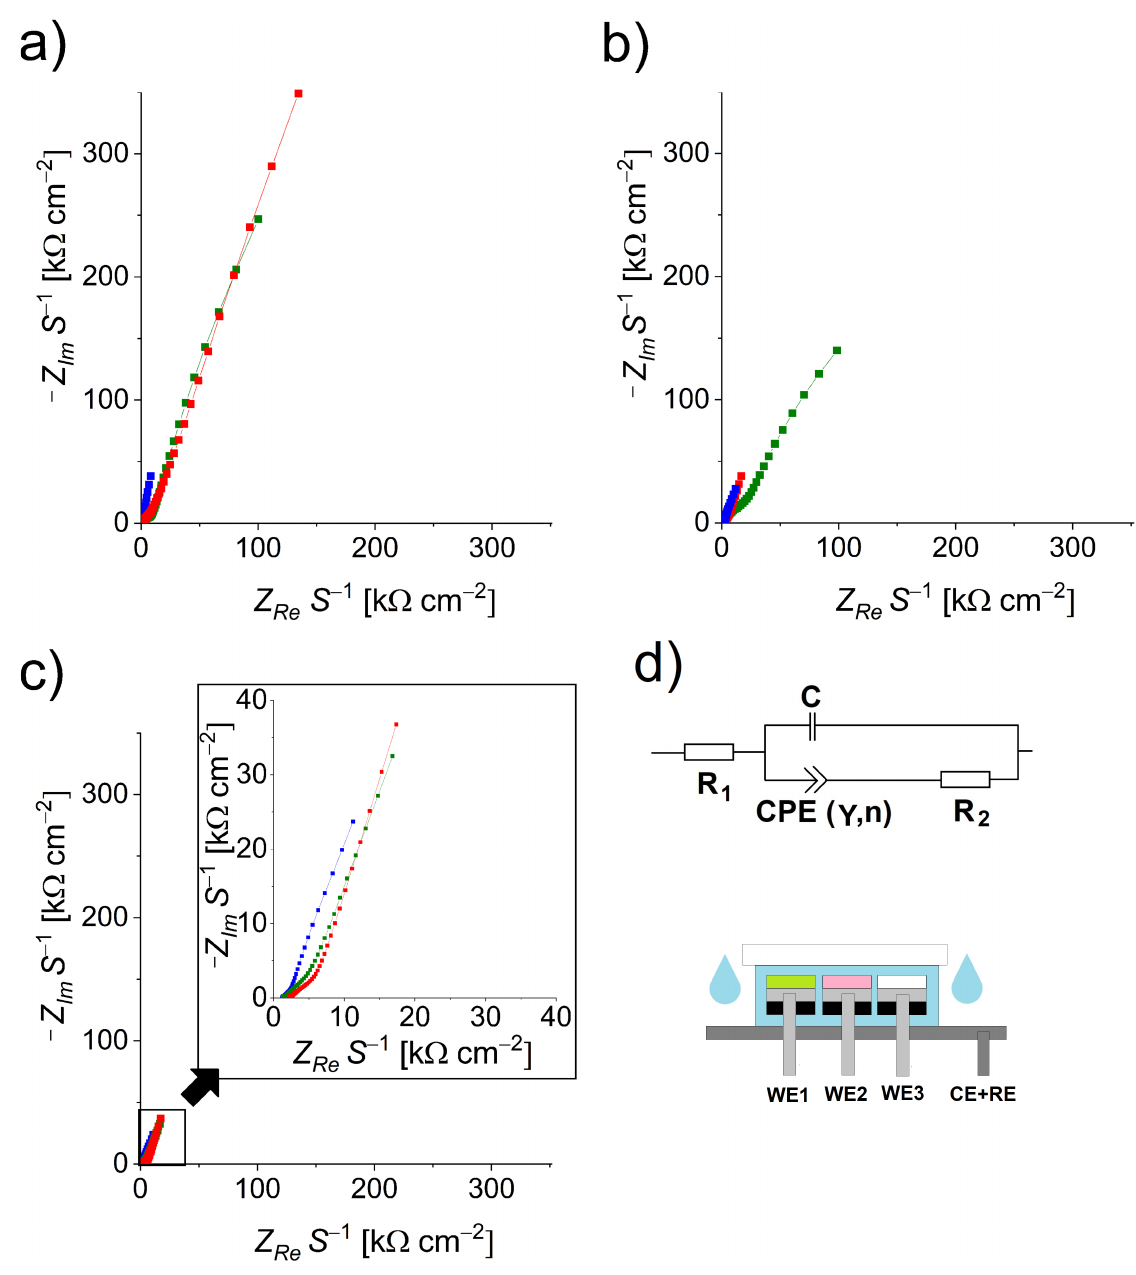
Figure 1. Nyquist plots of the assembled device exposed to different solvents: ( a ) water, ( b ) ethanol, and ( c ) THF, with a magnified plot. Each graph contains measurements for the three working electrodes: uncoated stainless steel (blue), coated with ethanol-susceptible thin film (red), and coated with THF-susceptible thin film (green). ( d ) Equivalent circuit used in fitting the experimental data along with schematics of the assembled device, showing the three separated working electrodes (WE1, WE2, and WE3) and combined reference/counter electrode (RE + CE). The impedances are normalized to the surface area of the working electrodes, S